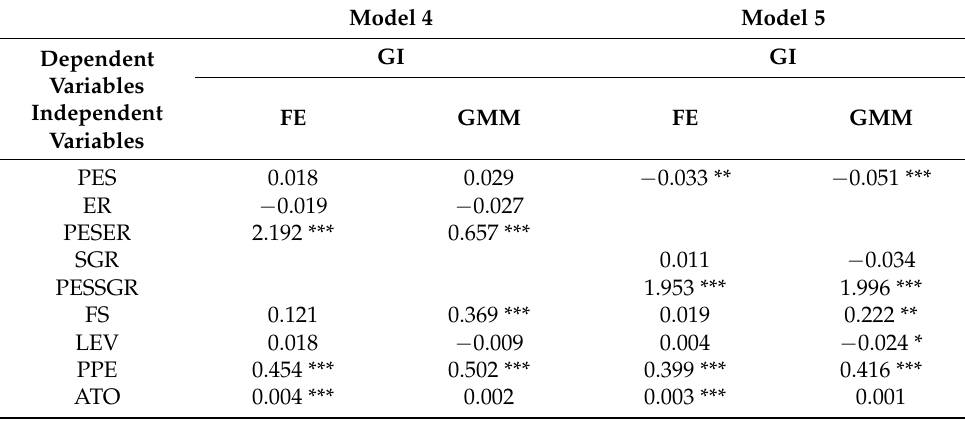
Table 4. The moderating results of environmental regulations and firm